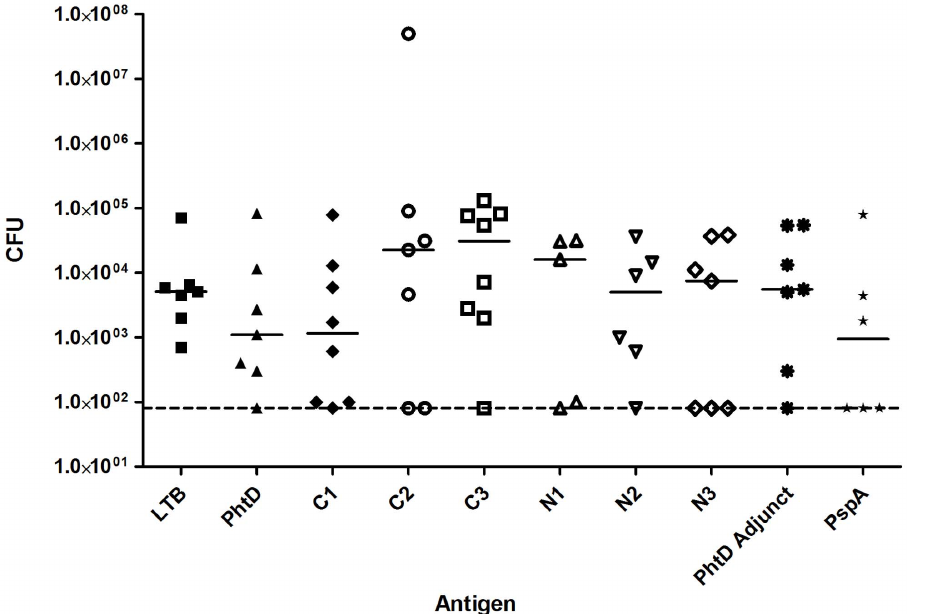
Figure 6. CFU of pneumococci recovered from the nasopharynges of vaccinated mice. After three immunisations with the indicated antigens, mice were challenged intranasally with wild-type D39 pneumococci. After 96 hours, pneumococci from the nasopharynx were enumerated. Median CFU recovered is indicated by the solid lines; the dashed line indicates the limit of detection. doi:10.1371/journal.pone.0078916.g006 PLOS ONE |